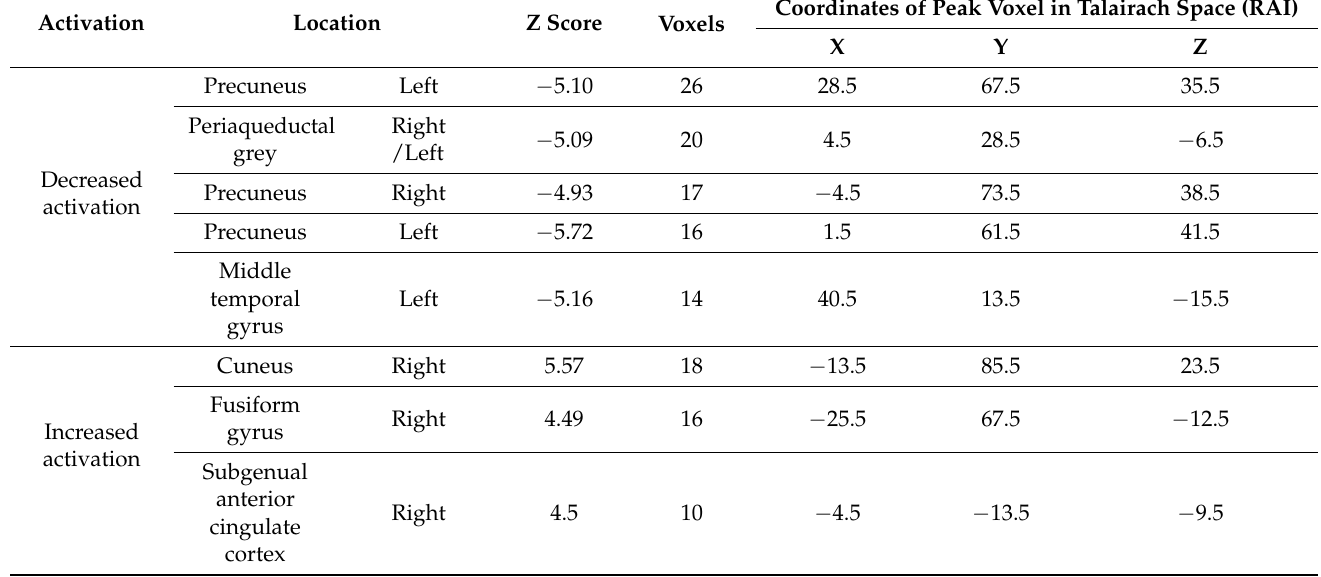
Table 1. Brain response to fearful faces when expecting somatosensory stimulation of the chest (CV17) compared to the control